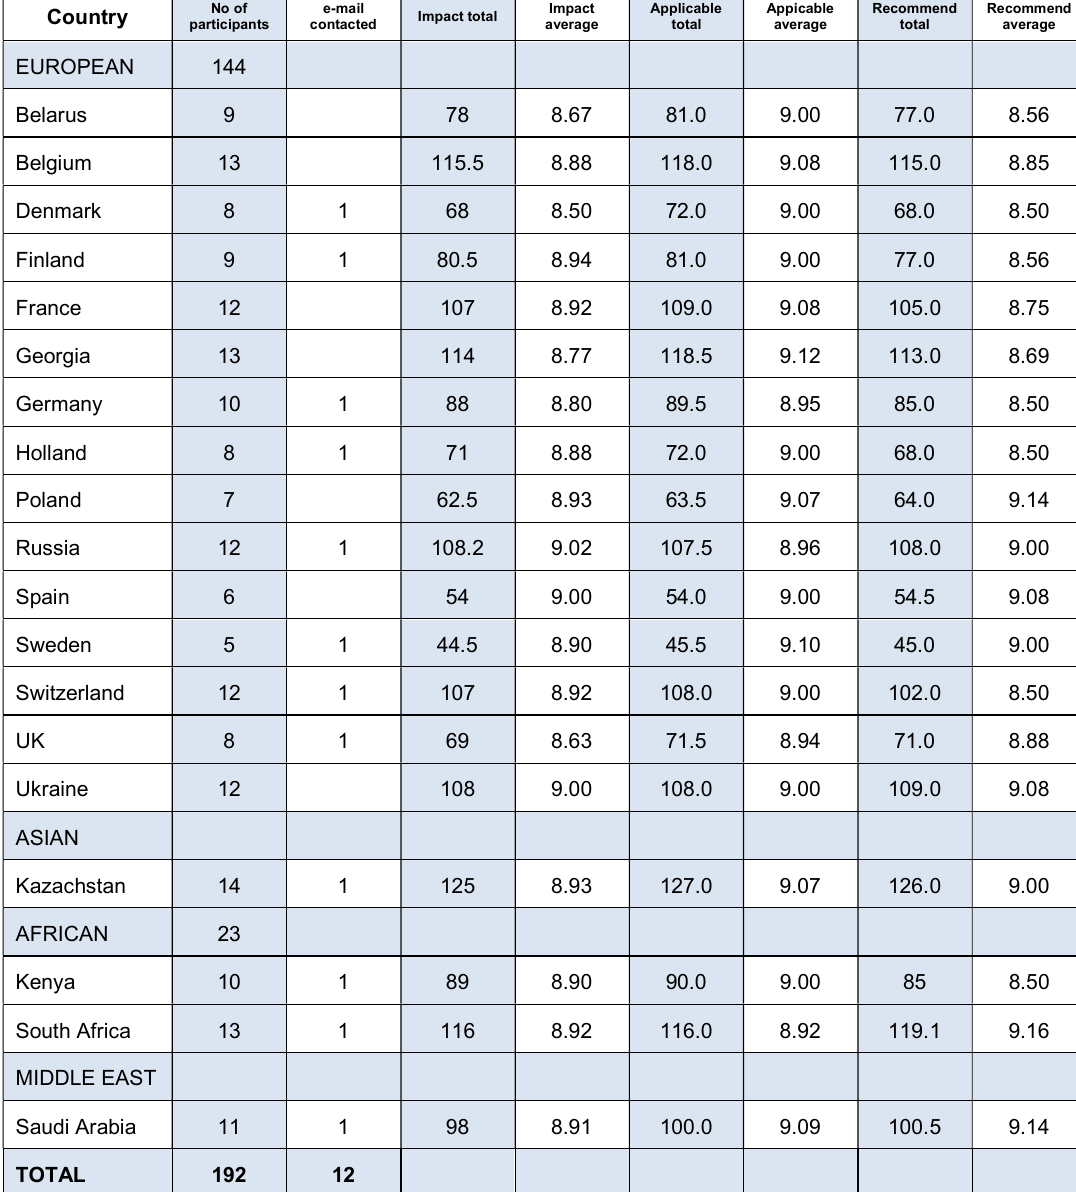
Table 1: Analysis of Feedback Forms Country No of